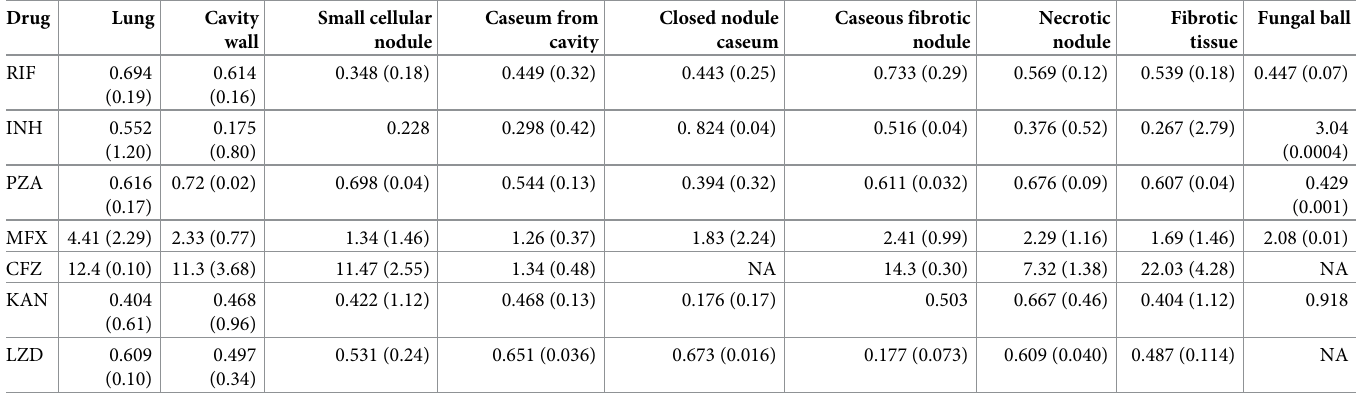
Table 3. Estimated drug lesion